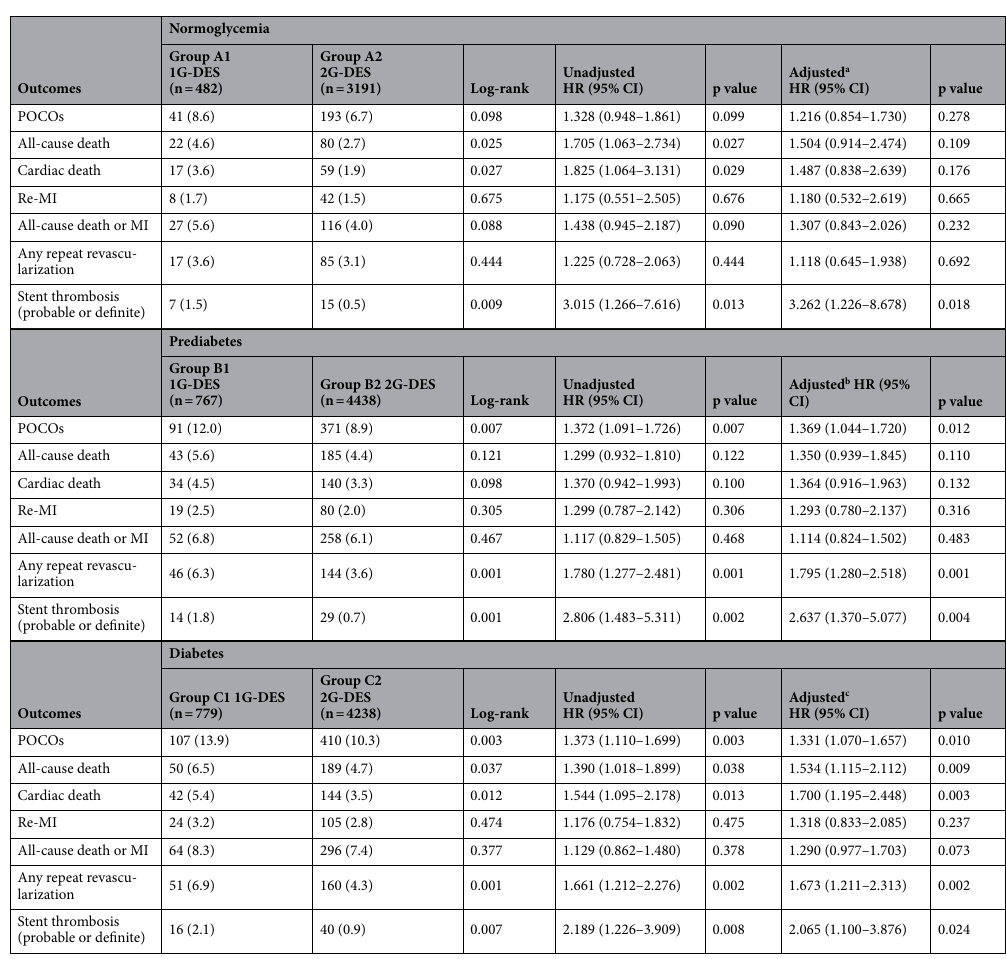
Table 2. Clinical outcomes between 1G-DES and 2G-DES at 2 years. POCOs patient-oriented composite outcomes defined as a composite of all-cause deaths, Re-MI or any repeat revascularization,